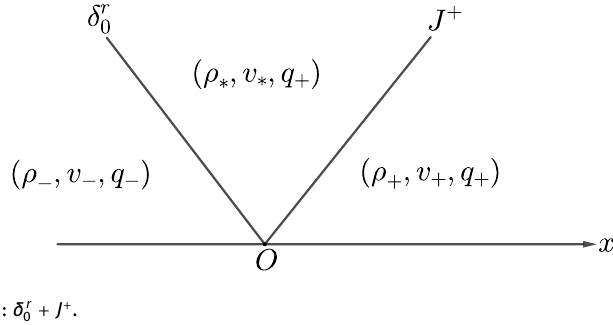
Figure 6: Riemann solution: + + δ J r 0